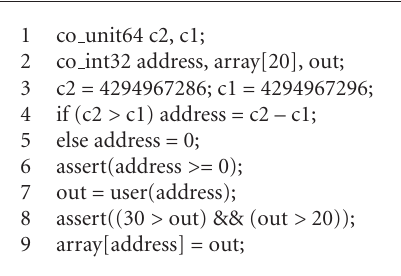
Algorithm 1: In-circuit verification example.